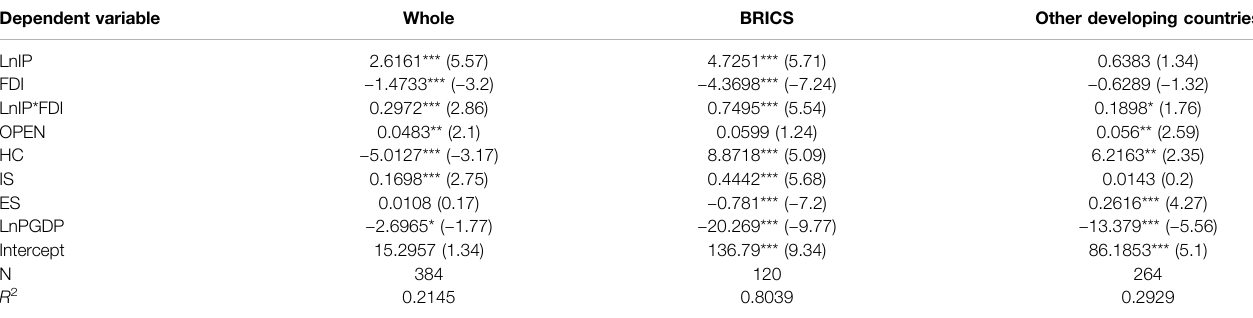
TABLE 4 | Moderating effect on IGP. Dependent variable